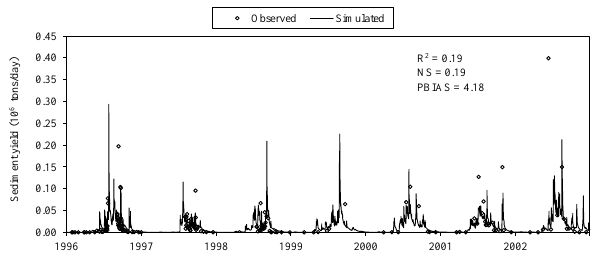
Fig. 9. Comparison of measured and simulated daily sediment yields for the calibration